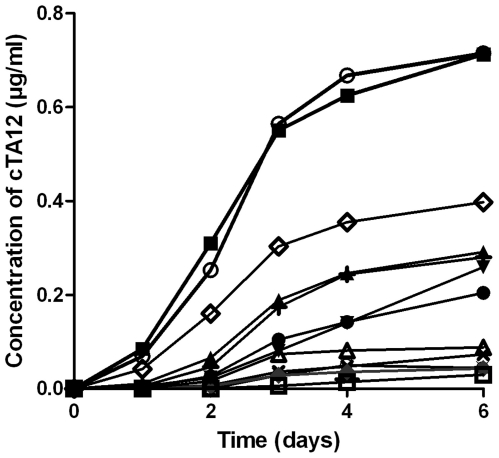
Productivity of different SP2/0-Ag14 clones secreting cTA12.6-well plates were seeded with 2.5×105 cells/well in 3 ml of medium culture. The productivity of 12 clones obtained after stable transfection and limiting dilution cloning was tested +12A1; ¤12A2; ▴13E1; X 13E4; ⧫13E5; •16C2; □16C4; ▵16G1; ▾16G2; ◊16G3; ○16G6; ▪16G7). Supernatants were harvested every 24 h to measure cell density and cTA12 concentration (by enzyme immunoassay).